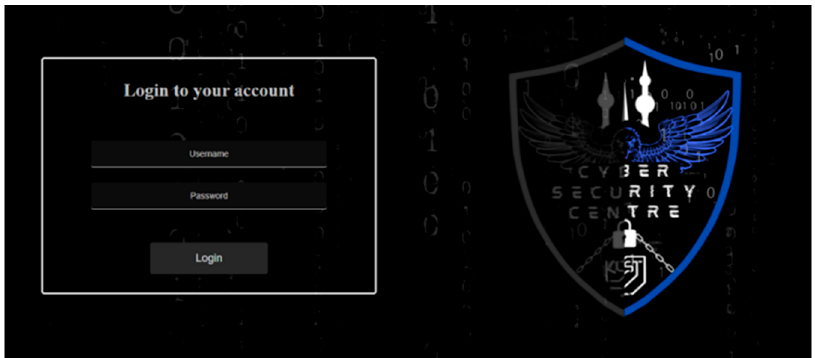
Figure 6. An example of the blue team’s login page.